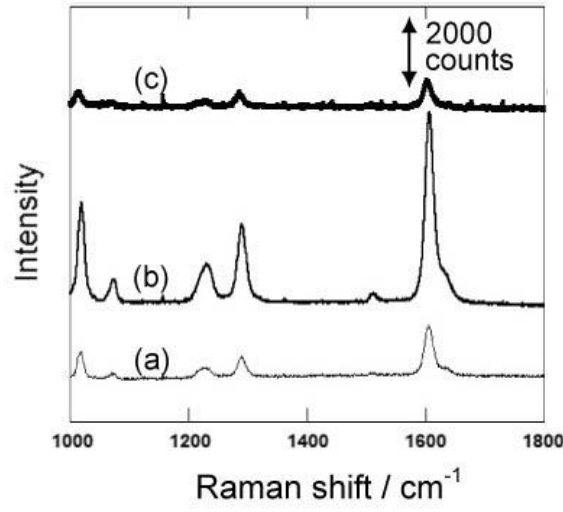
Figure 6. Raman Spectra of 4,4’-bipyridine using the gold-embedded porous silicon substrates with different nanorod lengths (different depths). The length of the